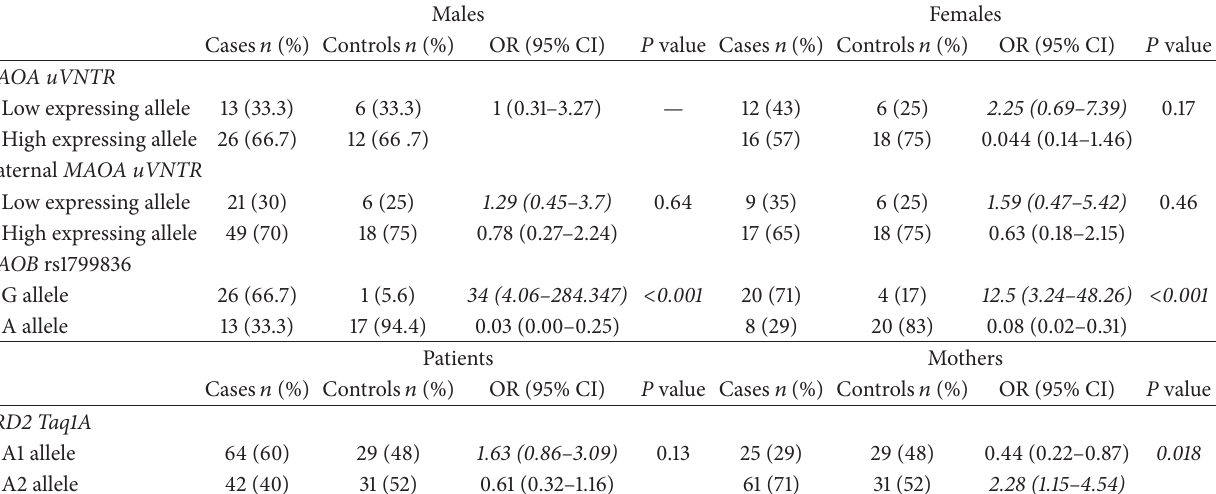
Table 2: Allele frequencies MAOA uVNTR; MAOB rs1799836 and DRD2 Taq1A . Males